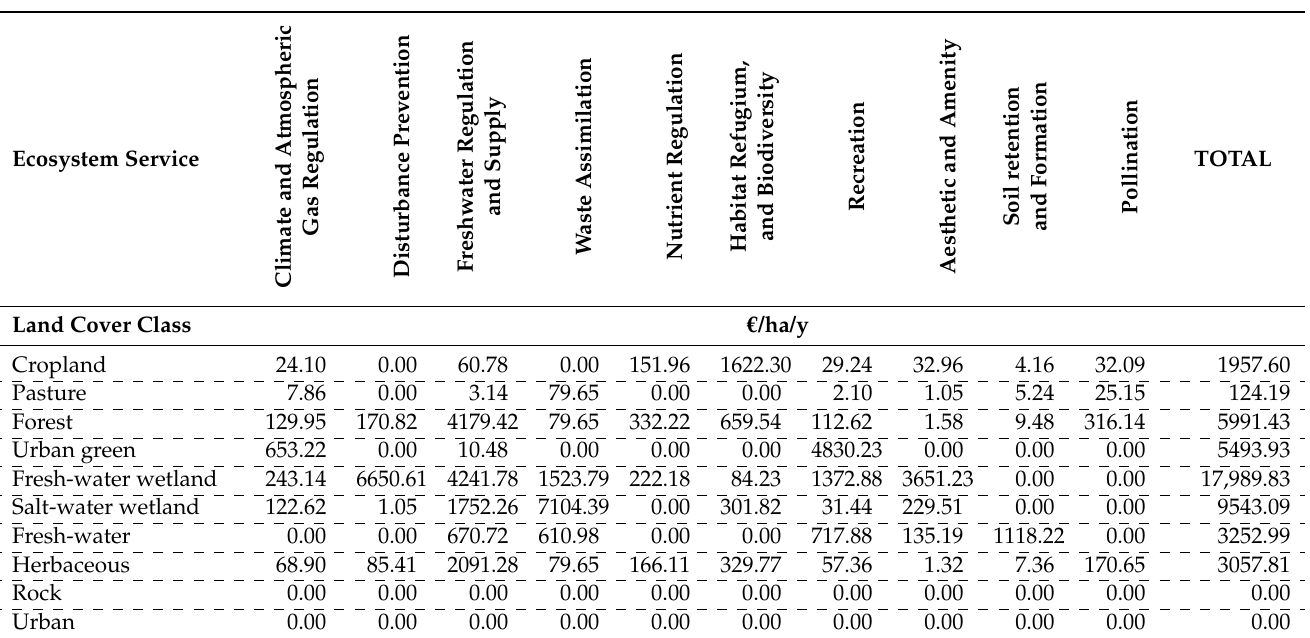
Table 1. Baseline monetary values ( € /ha/y), according to type of ES (column) and land cover classes